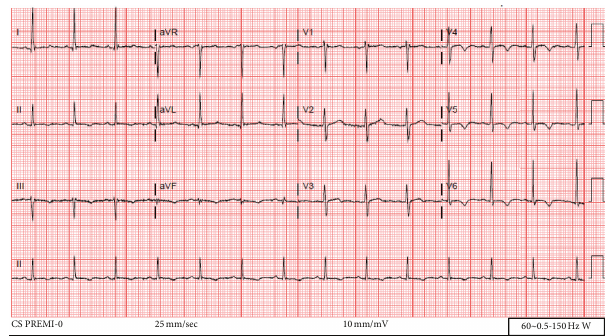
Figure 1: EKG suggests LVH and T-wave inversion in leads V4–V6.